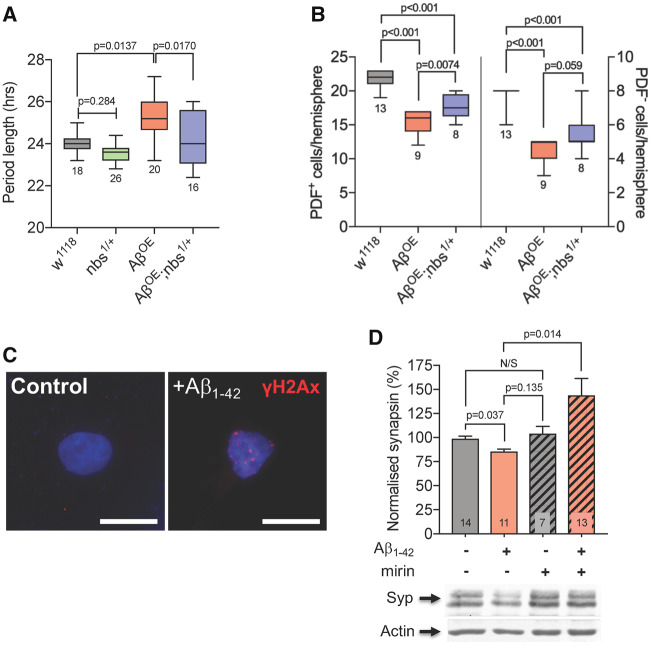

Targeting the MRN complex protects against Alzheimer’s disease-relevant phenotypes. (A) Expression of Aβ1-42 in clock neurons leads to loss of Per+ cells. In nbs−/+ flies, loss of cells is partially prevented (Kruskal–Wallis with Dunn’s post hoc test; P-values and n are indicated). (B) The free-running circadian locomotor cycle of control flies is approximately 24 h but is considerably lengthened when Aβ1-42 is expressed in clock neurons indicating weaker rhythmicity in the circadian circuitry. The increase is suppressed in nbs1/+ flies (CLEAN spectral analysis; comparisons by ANOVA with Tukey’s post hoc test; P-values and n are indicated). (C) Exposure of rat hippocampal neurons to Aβ1-42 oligomers in vitro generate double-strand breaks that can be visualized by staining with anti-γH2Ax (red). DNA is visualized with DAPI (blue). (D) Quantification of synapsin levels in hippocampal neurons by western blot. Exposure to Aβ1-42 oligomers leads to loss of the pre-synaptic protein, synapsin, which is reversed by the Mre11 inhibitor, mirin (mean ± SEM; ANOVA with Tukey’s post hoc test; P-values and n are indicated). Scale bars in C = 10 µm.